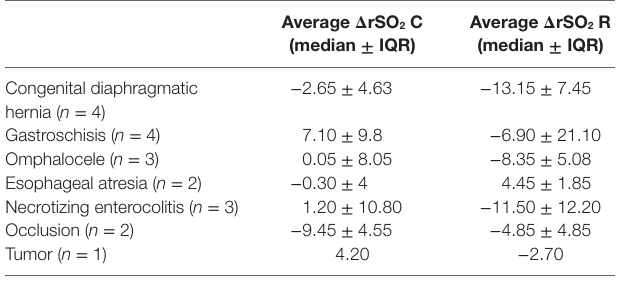
TaBle 2 | Average variation of C rSO 2 and R rSO 2 according to the